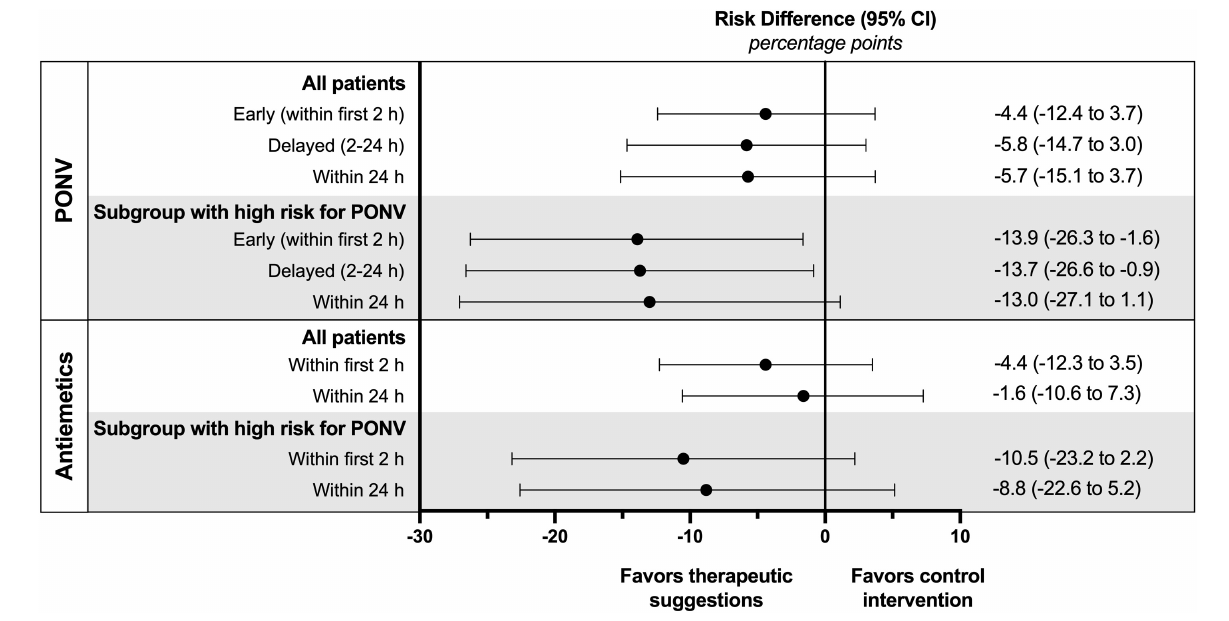
FIGURE 3 | Absolute risk differences of PONV incidence and postoperative use of antiemetics for all patients and subgroup of patients with a high risk for PONV (defined by an Apfel score of 3 or 4). TABLE 3 | Correlation between PONV severity and dose of antiemetics. Intervention group Control